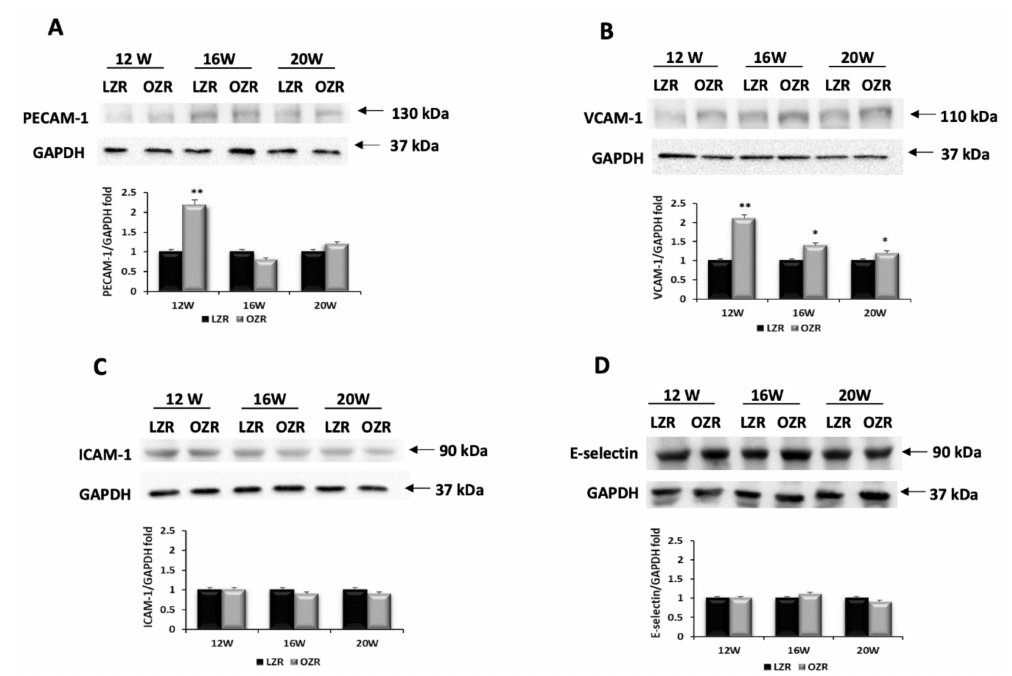
Figure 4. Inflammation. Lysates of heart from lean Zucker rats (LZR) and obese Zucker rats (OZR) at 12, 16, and 20 weeks of age, were immunoblotted using specific antibodies against: ( A ) platelet endothelial cell adhesion molecule-1 (PECAM-1); ( B ) vascular cell adhesion molecule-1 (VCAM-1); ( C ) intracellular adhesion molecule-1 (ICAM-1); ( D ) E-selectin. Values indicate the ratio of densitometric analysis of bands and GAPDH levels used as loading control, considering the LZR group as reference. Data are mean ± S.E.M. * p < 0.05 and ** p < 0.01 vs. age matched LZR. Blots are representative of one of three separate experiments.